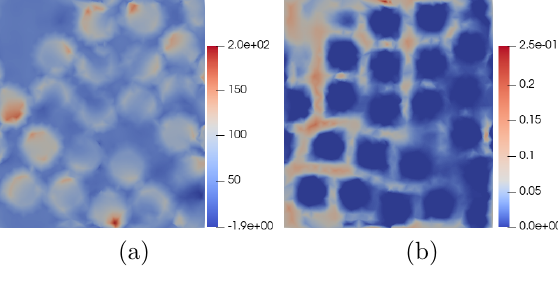
Figure 16. Carbon composite with minimal stiffness, time = 50 s: a) Shear stress [MPa], b) creep strain.